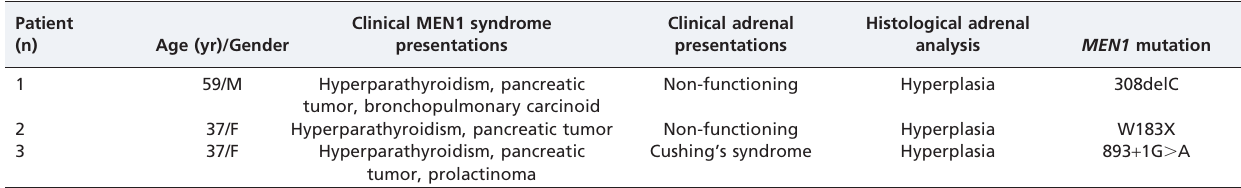
Table 1 - Clinical, histological and molecular data from 3 patients with MEN1 syndrome and adrenal disorders. Patient (n) Age